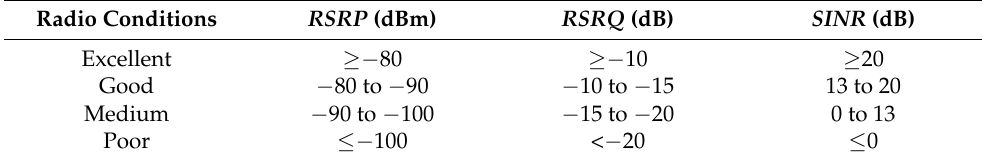
Table 3. Key performance indicators value ranges for coverage and mobility optimization use cases. Radio